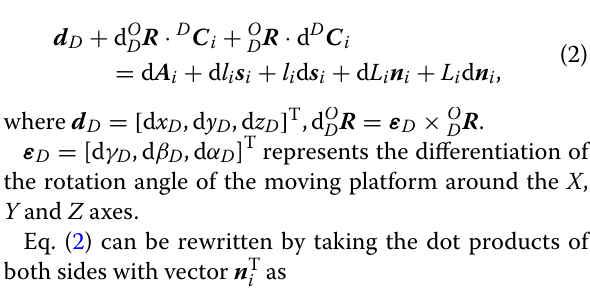
K = J − 1 [ E 5 G L G C G A G 5 ] W with , where K repre- δ p = [ δ Λ T δ L T δ C T δ A T δ S T ] (cid:31) sents the mapping matrix of geometric error. δ p denotes the geometric error source of the parallel D C , δ A mechanism. In δ and δ S , there are errors in the x , y and z axis directions. δ p of Eq. (5) includes 11 error sources of the paral- lel mechanism. Among them, the z -direction error of linear actuator apex δ A z is 0. Since the direction vec- tor of linear actuator along the x , y and z axes of the three errors are not independent of each other, two independent error parameters (declinations δϕ and δθ ) are used to facilitate the analysis of error sensitivity, as shown in Figure 3. ′ − ϕ , δθ = θ ′ − θ . In Figure 3, δϕ = ϕ The relationship between δϕ , δθ and δ s x , δ s y , δ s z can be expressed as